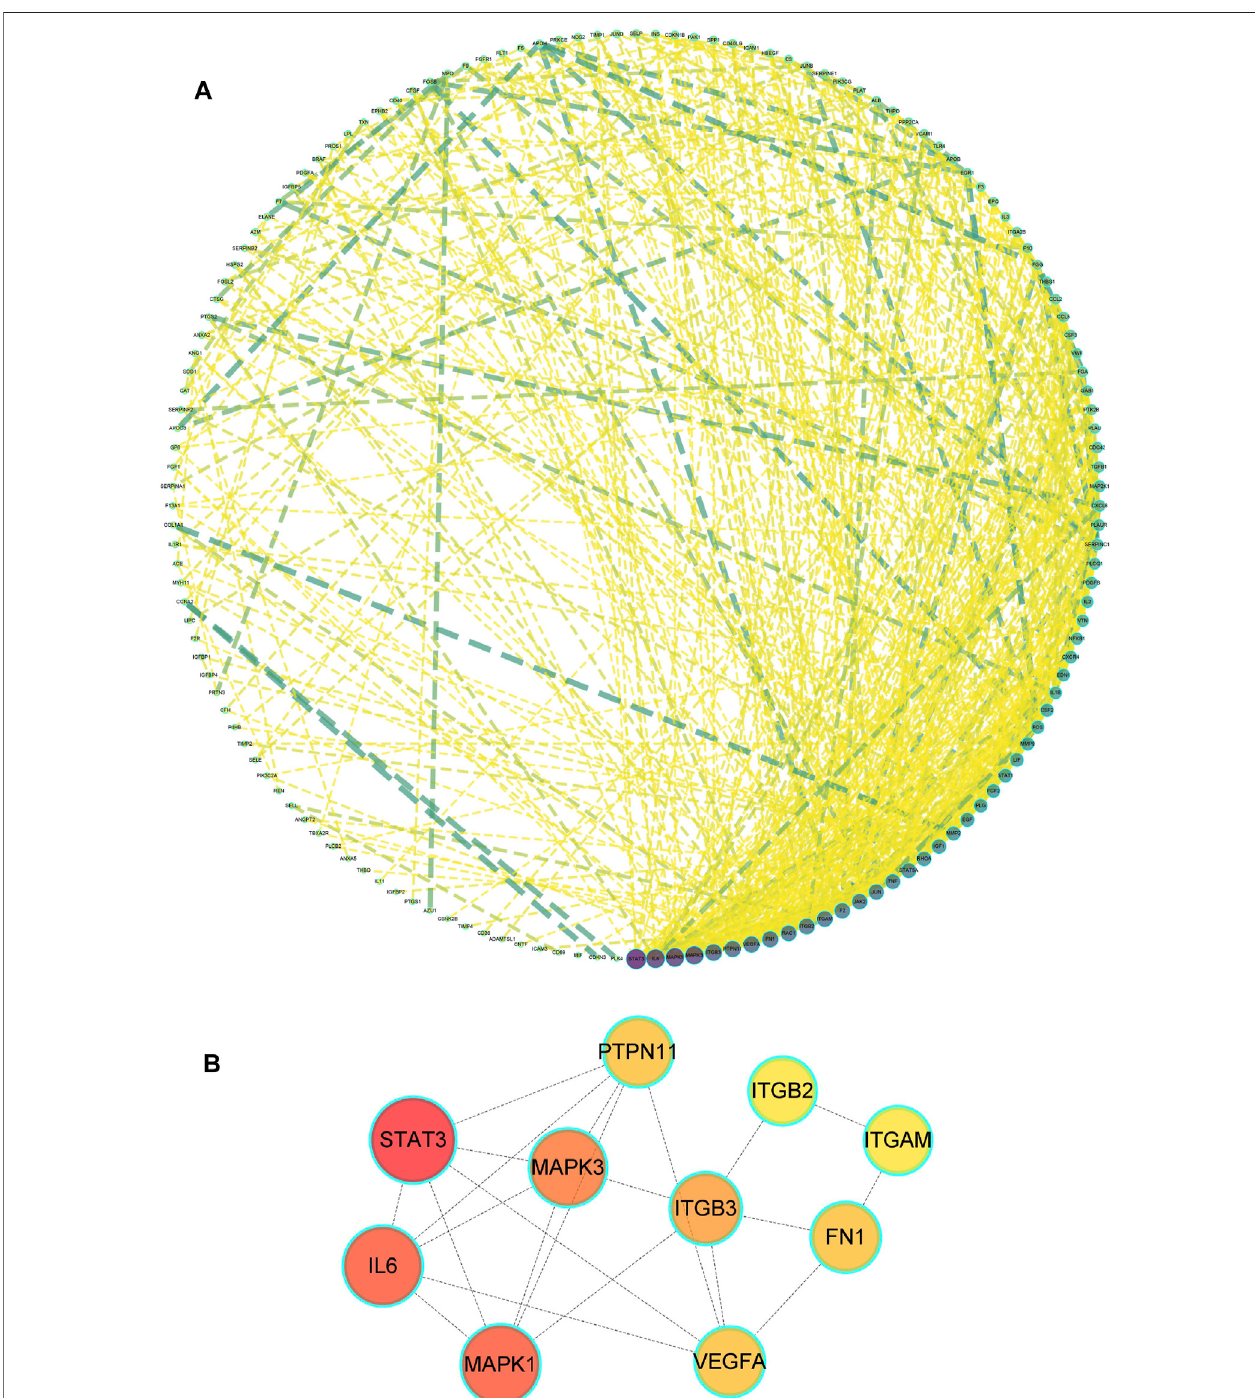
FIGURE 3 | Drug-disease PPI network. (A) The network contains 185 gene nodes and 3,656 edges. Yellow circles represent gene targets. Purple nodes have a higher degree. The node size of the gene target is proportional to the degree. (B) The hub network was obtained by screening.